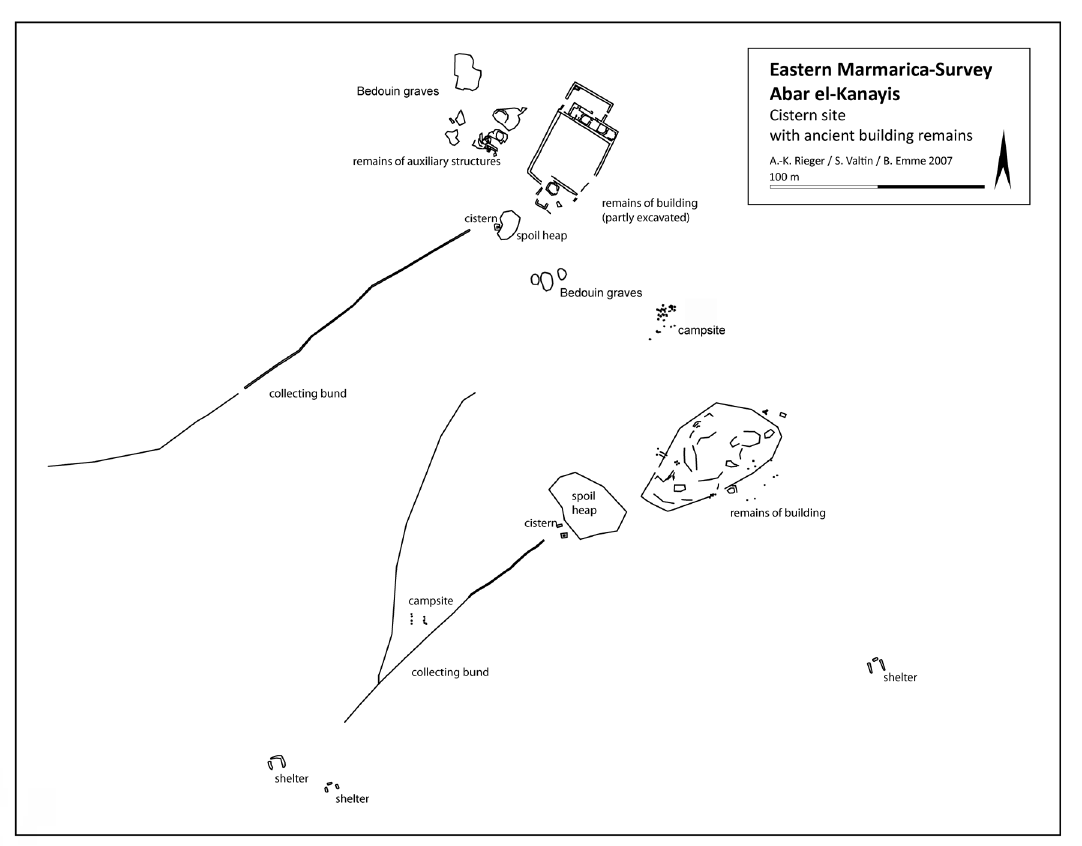
Fig. 9. The cistern site Abar el-Kanayis on the Northern Marmarica-Plateau with the two cisterns and their conducting bunds, and the two buildings of which the northern one was partly